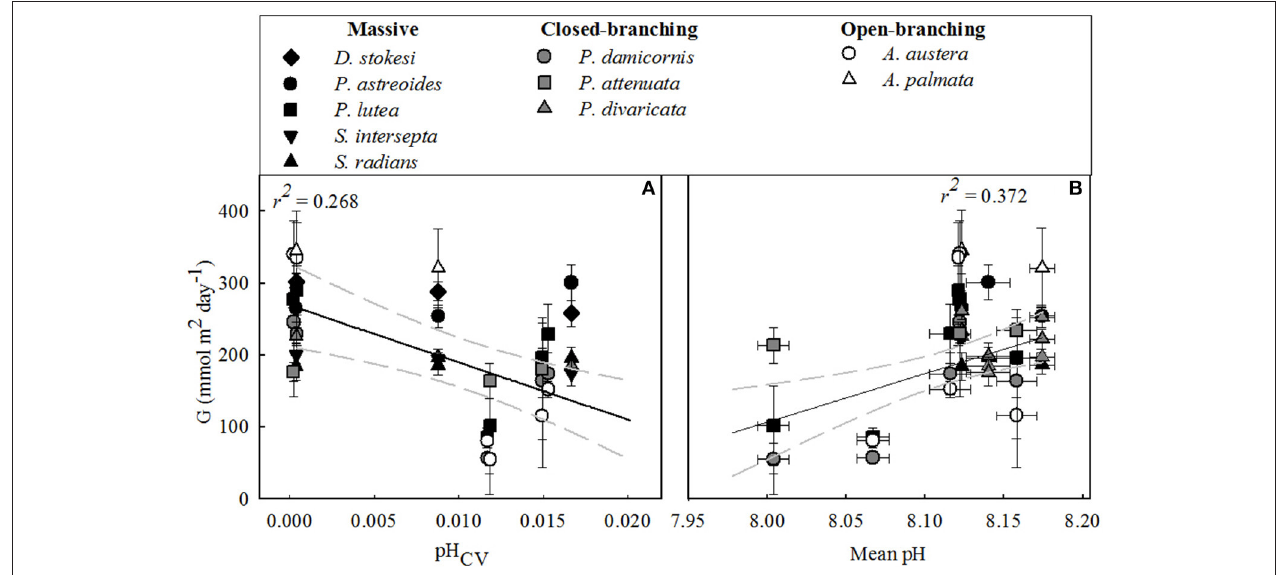
FIGURE 4 | Mean daily integrated net calcification for each coral species (G) (mmol m 2 day − 1 ) vs.: (A) pH Coefficient of Variation ( CV ) and (B) mean pH. All data plotted are mean values ( n = 5 ), ± standard error except for pH CV (see main text) for the dominant coral species examined across associated-reef habitats (seagrass, back-reef and mangrove) and outer-reef habitat for all bioregion sites. Regression is shown with 95% confidence interval (gray dashed